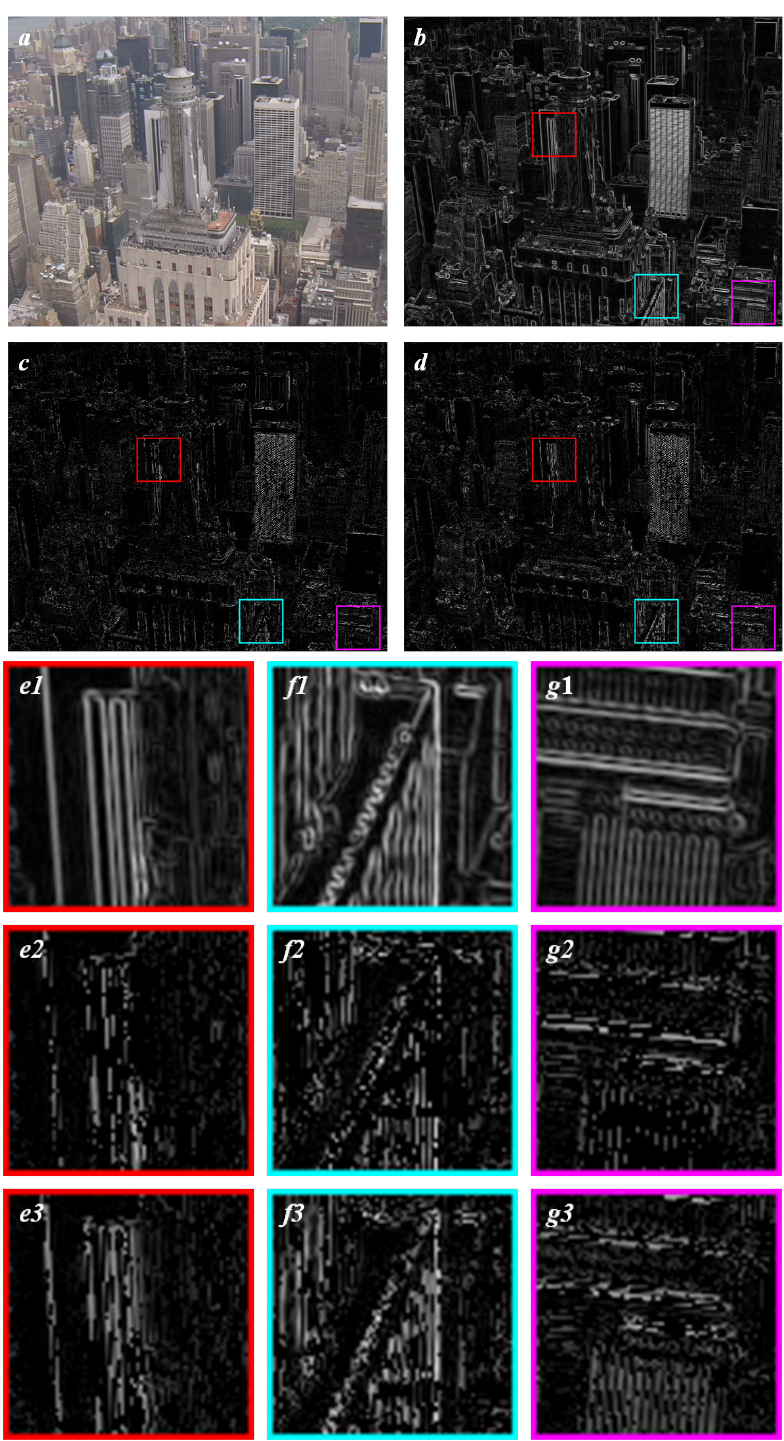
Figure 6. Texture of reconstruction results between proposed method and SOF-VSR method on city video sequence of Vid4 dataset. Figure ( a ) is the label image, and Figure ( b ) is the texture image processed by the Sobel operator of the label image; Figure ( c ) shows the dominant pixel distribution of the reconstruction result of SOF-VSR method in the texture region, and Figure ( d ) shows the dominant pixel distribution of the reconstruction result of proposed method in the texture region; Figures ( e1 , f1 , g1 ) show the enlargement of the local texture area of the label image, Figures ( e2 , f2 , g2 ) show the enlargement of the result local area of the SOF-VSR method, and Figures ( e3 , f3 , g3 ) show the enlargement of the result local area of the proposed